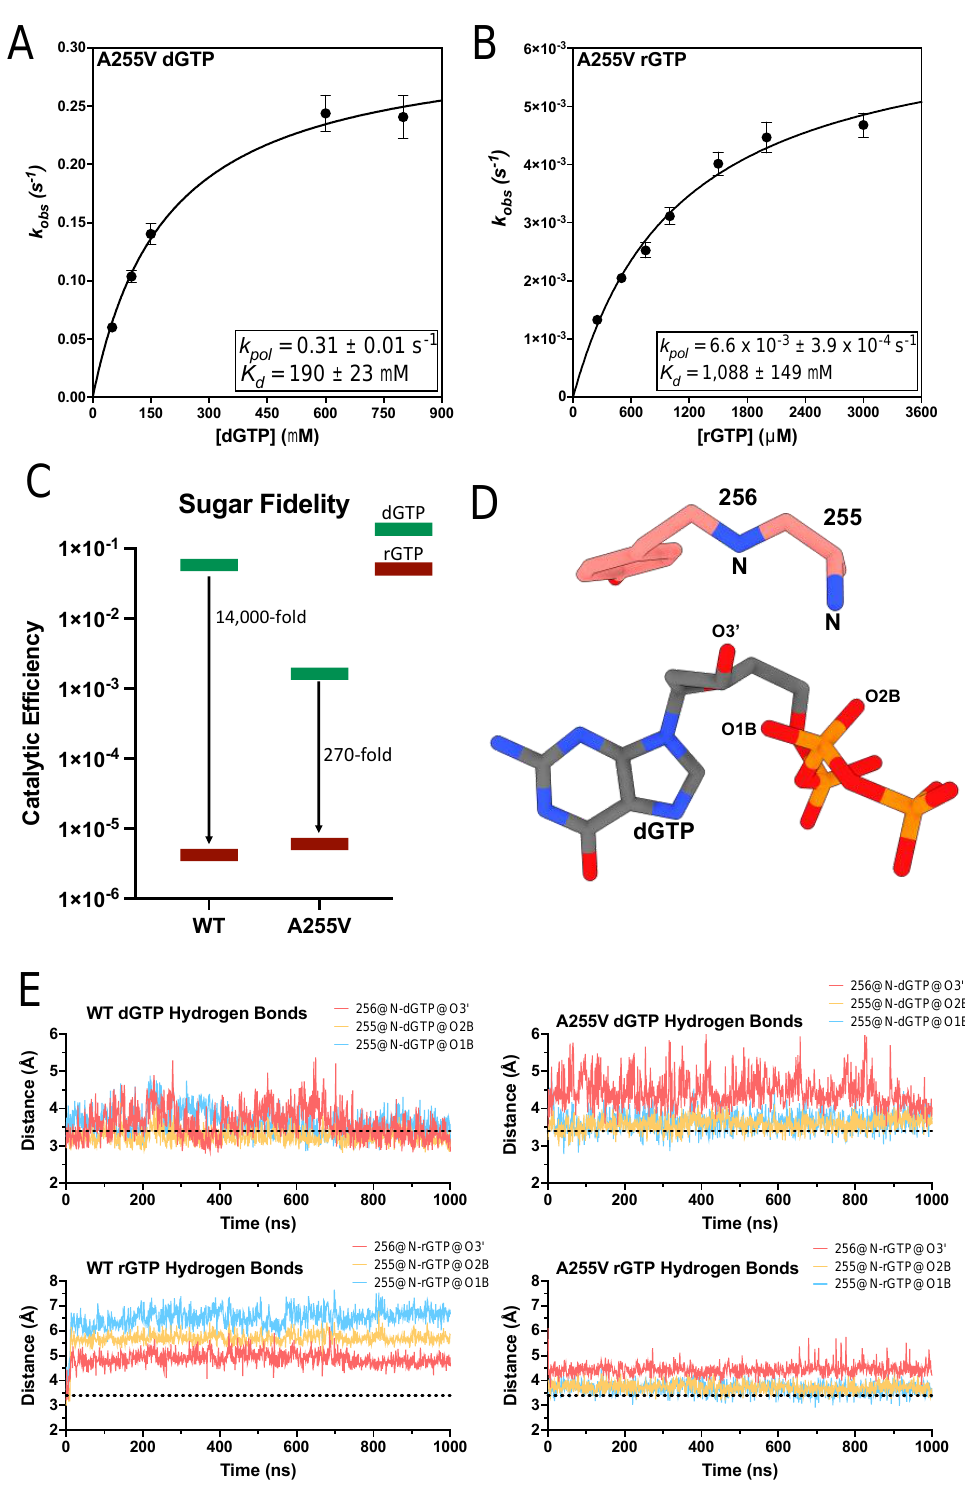
Figure 5. Mechanism of A255V nucleotide insertion. ( A ) Replot of k obs values from single-turnover kinetics of A255V inserting dGTP across from a templating rC with the k pol and K d indicated. ( B ) Replot of k obs values from single-turnover kinetics of A255V inserting rGTP across from a templating rC with the kpol and K d indicated. ( C ) Sugar fidelity for WT and A255V. WT values are taken from a previous publication [22]. ( D ) Atom identifiers involved in hydrogen bonds with the incoming nucleotide. ( E ) Trajectories of the distance between indicated atom pairs and dGTP or rGTP. A distance cutoff of 3.4 Å was used to determine hydrogen bonding and is indicated by the black dashed line.